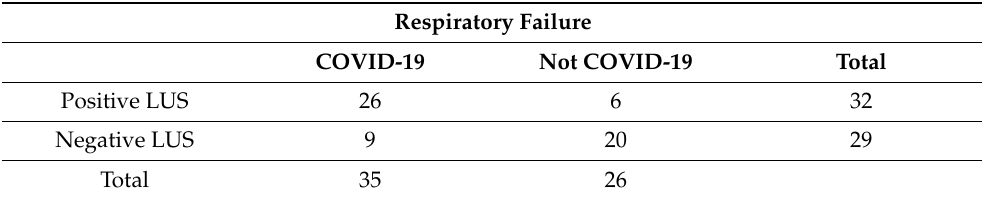
Table 8. 2 × 2 contingency table for LUS, considered positive in the presence of diffuse AIS without pleural effusion.